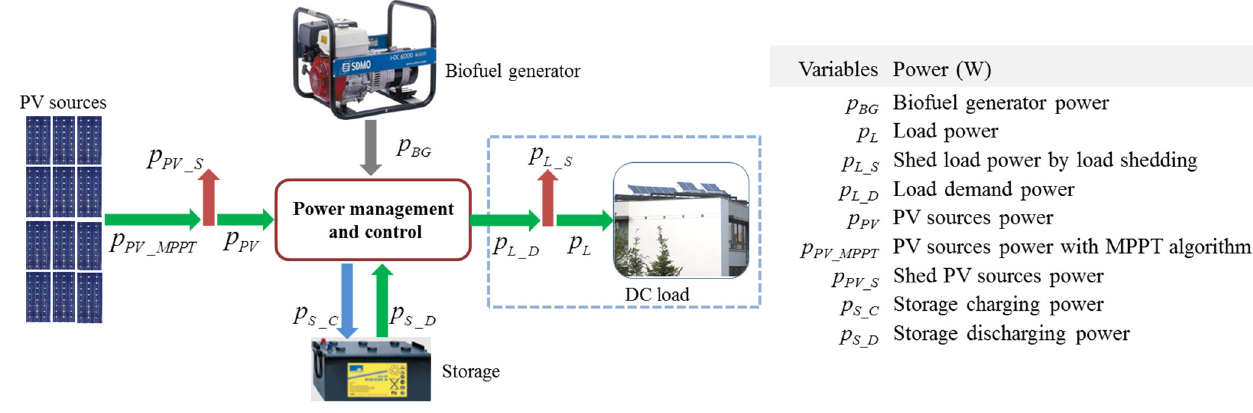
Figure 2. Power flow